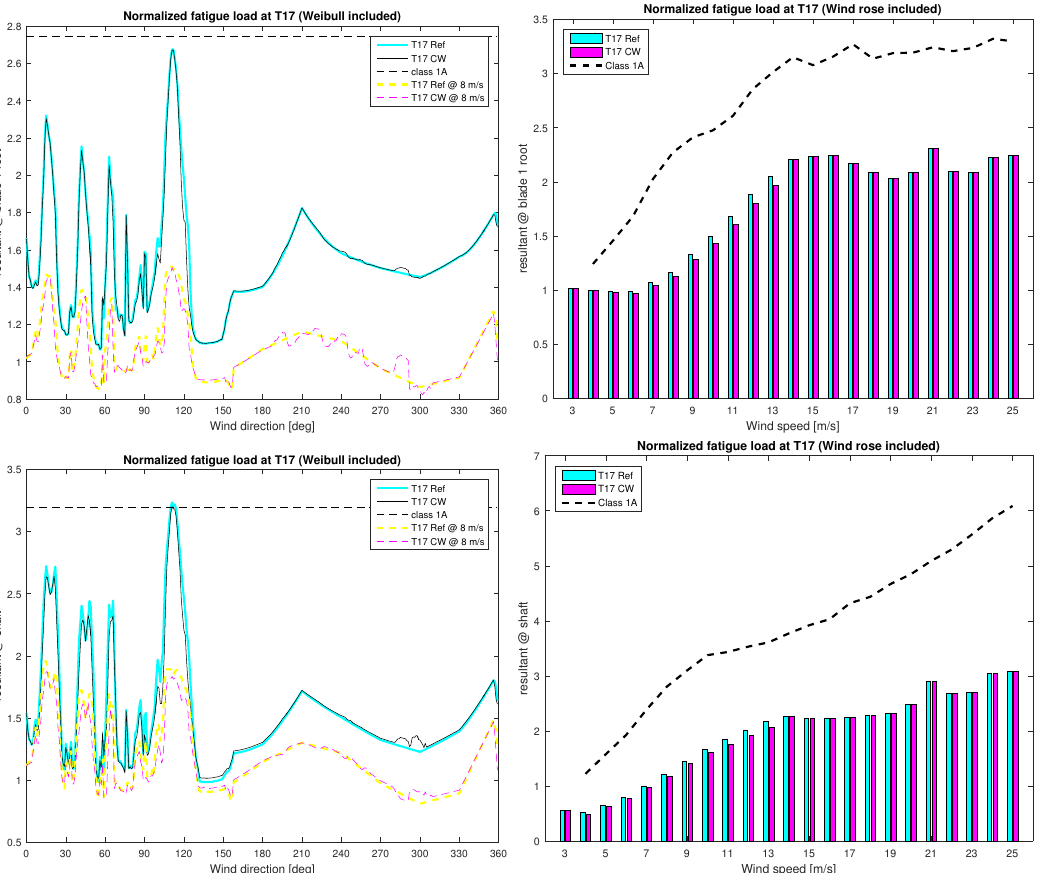
Figure 8. Normalized fatigue loads at turbine 17 versus wind direction ( left plots ) and wind speed ( right plots